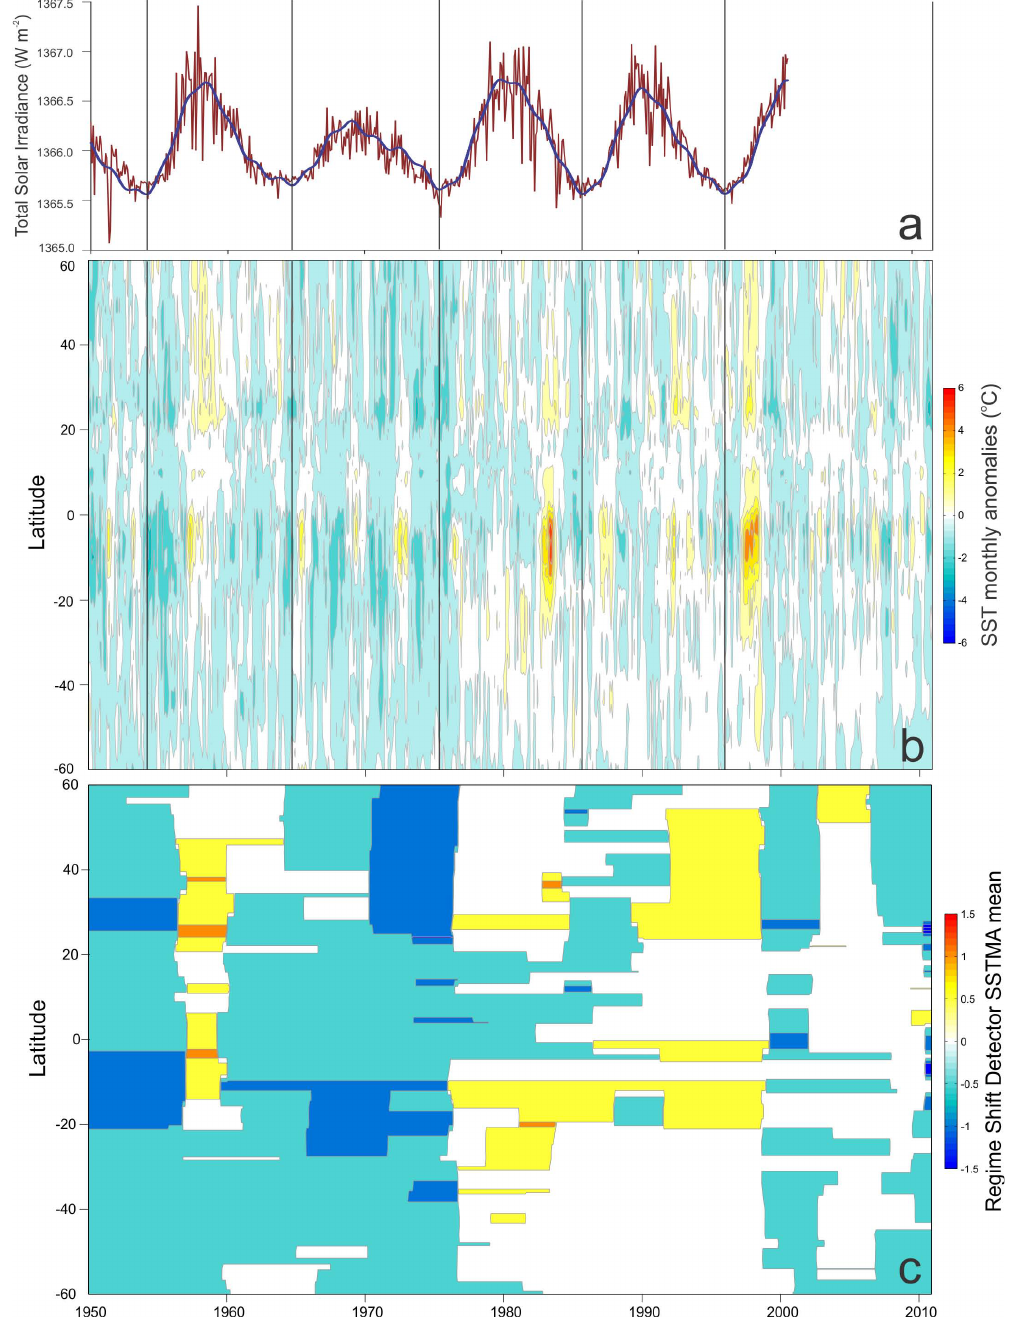
Fig. 2. Total solar radiation (a) , Hovm¨oller diagram of the SST monthly anomalies (b) and the same type of diagram for RSD applied to SST monthly anomalies (c) . The colorbar in 2c represents the mean value for the regime detected trough RSD in the same units as SST (°C).